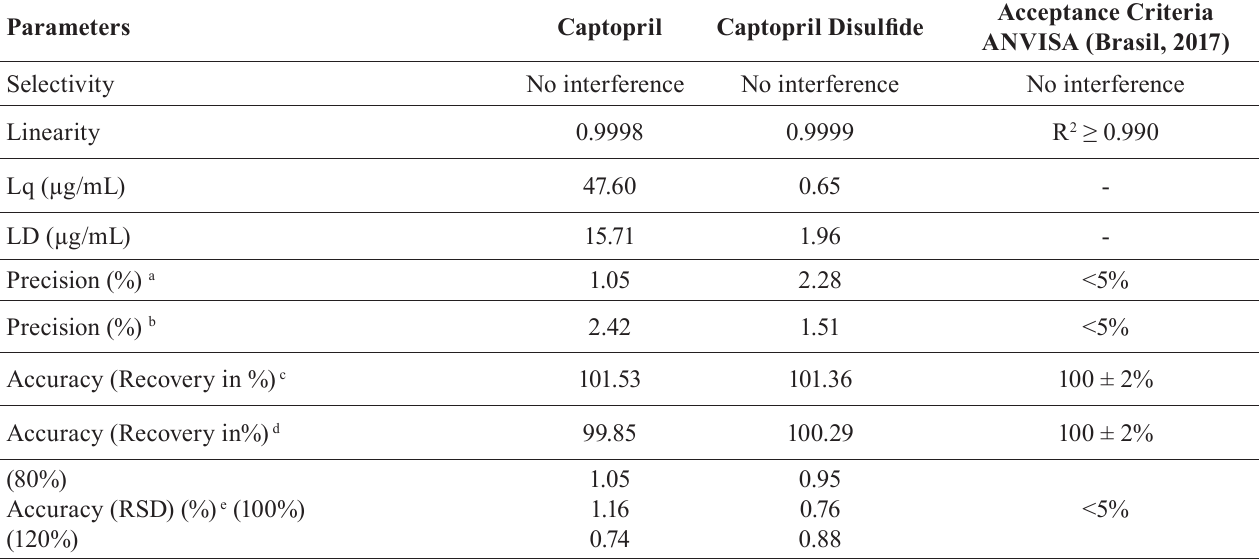
TABLE III - Analytical Method Validation Results